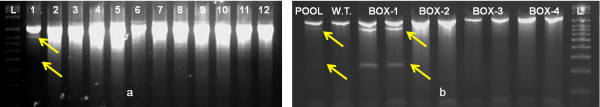
Mutant identification in 4x pools and subsequent deconvolution. (A) Identification of a mutant pool in lane 1. (B) Deconvolution to identify a mutant individual. In the de-pooling for each plate the first lane has M2 plant DNA and second lane has M2+wild type DNA. Plant in Box-1 is heterozygous for mutation.